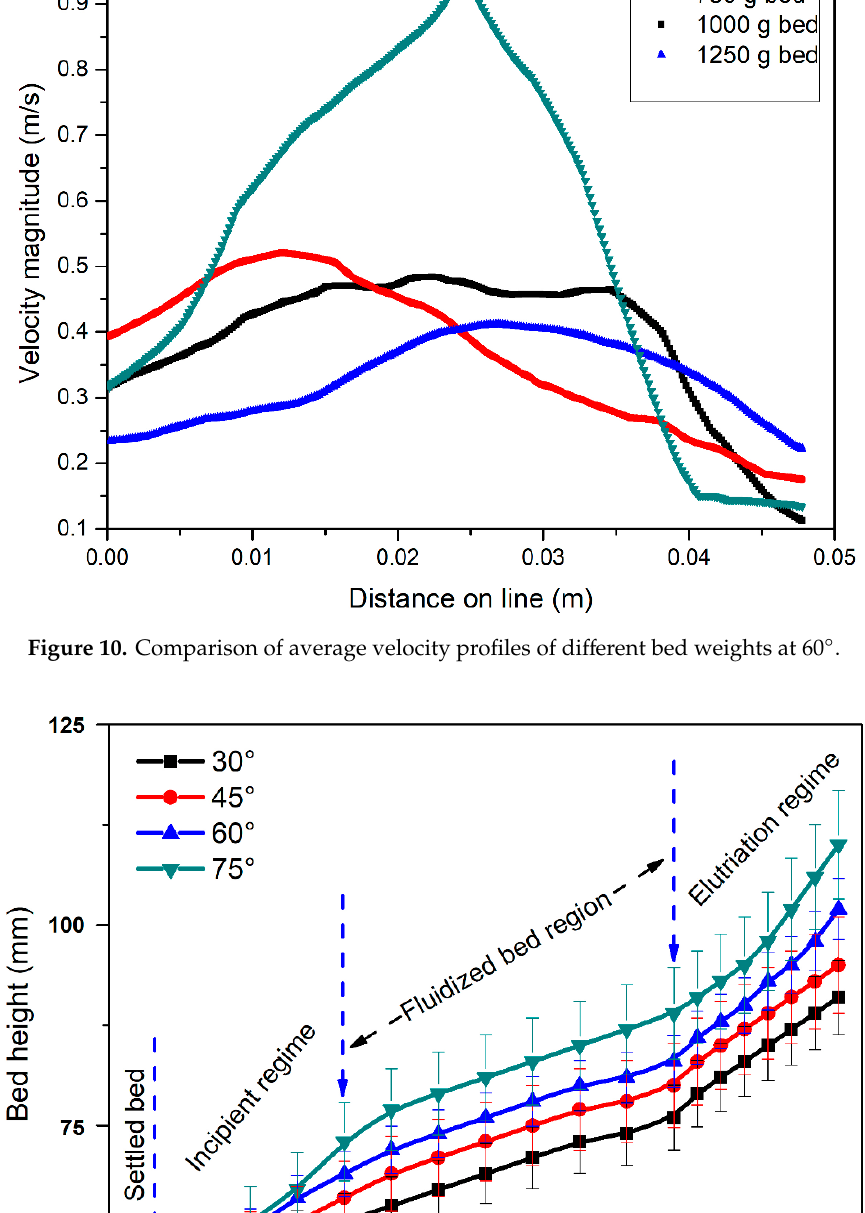
Figure 11. Illustration of bed height and flow response to superficial velocity at different blade angles.